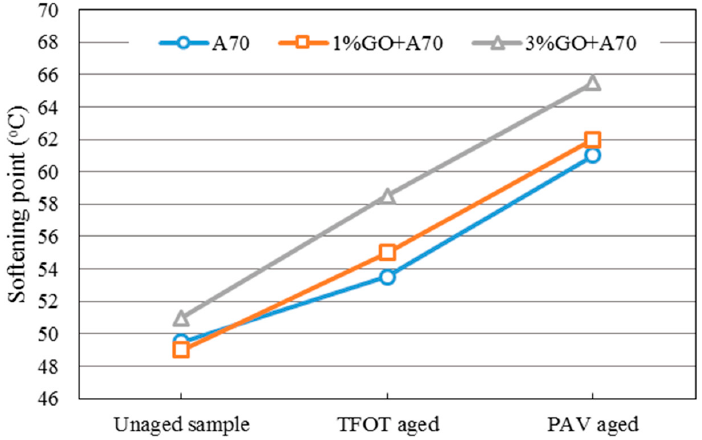
Figure 3. Softening point of GO-modified 70A and its matrix before and after aging.